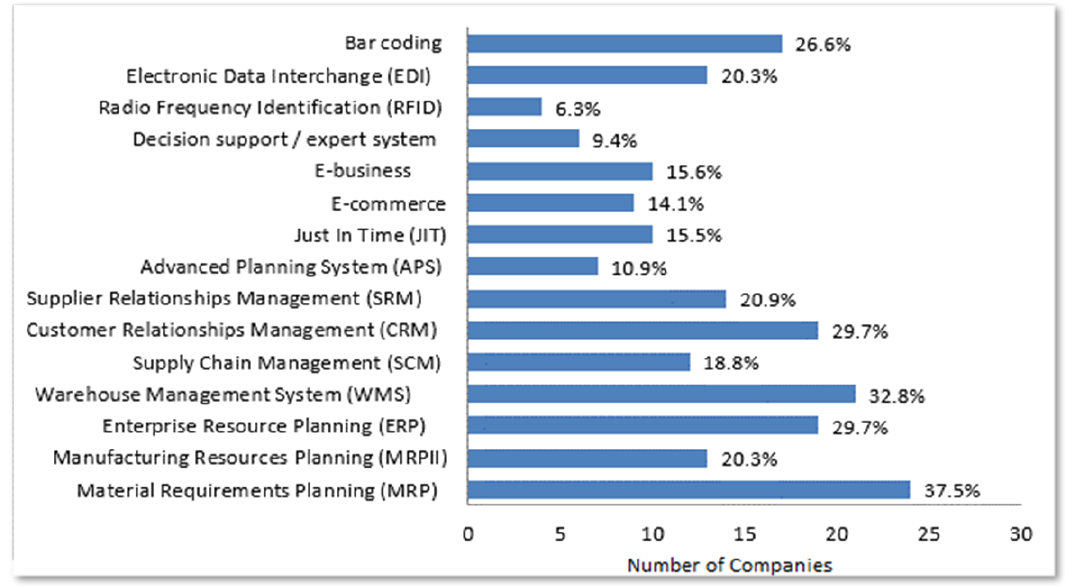
Figure 6. Current use of